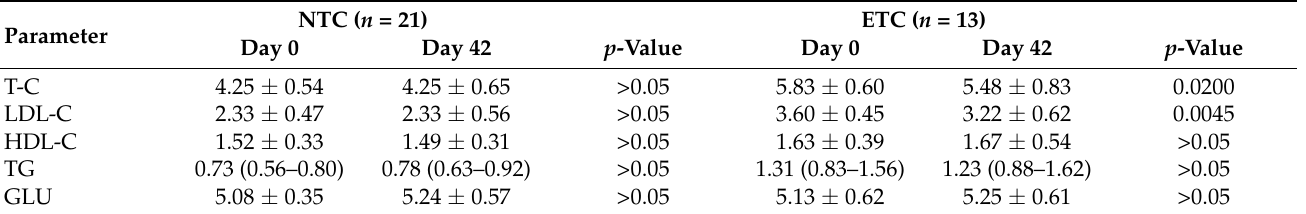
Table 4. Lipid profiles and fasting glucose of the subjects before and after apricot seeds consumption (mmol/L).